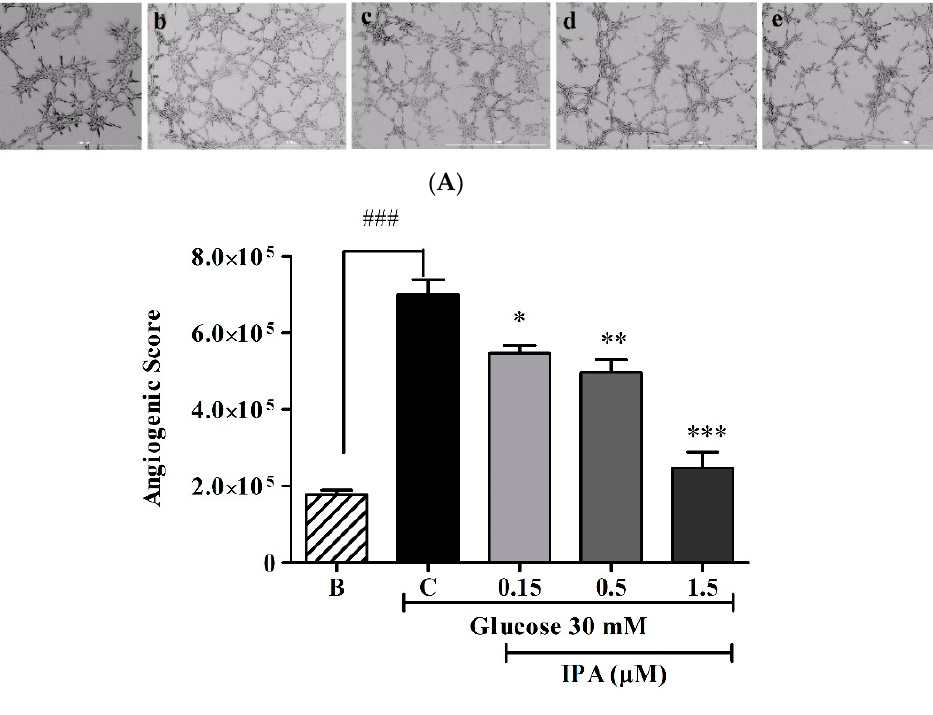
Figure 5. ( A ) IPA suppresses high glucose-induced capillary formation in Matrigel ® . The cells were seeded on Matrigel ® with different concentrations of IPA (0.15, 0.5, and 1.5 µM), along with 30 mM glucose including B (blank (0 mM glucose + 0 µM IPA)) and C (control (30 mM glucose + 0 µM IPA)). After 6 h incubation, the cells were photographed and the angiogenic score was determined. ( B ) Quantification of capillary formation. The effects of 30 mM glucose on capillary formation were compared to B (blank (0 mM glucose + 0 µM IPA)). The effects of IPA on high glucose-induced capillary formation were normalized to C (control (30 mM glucose + 0 µM IPA)). Scale bar (A) 1000 µm. * p ˂ 0.05, ** p ˂ 0.01, *** p ˂ 0.001, ### p ˂ 0.001.